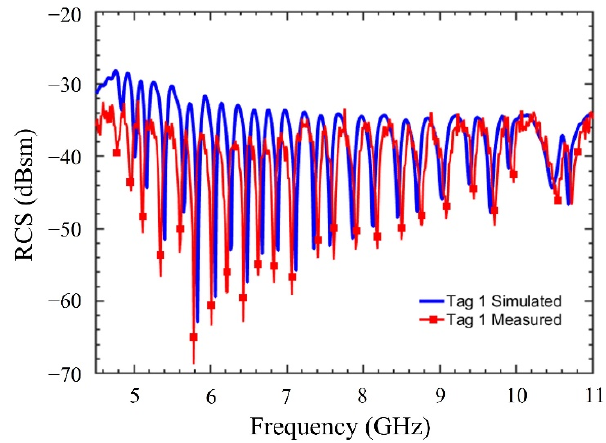
Figure 8. Measured and simulated RCS response of tag instance Tag 1.